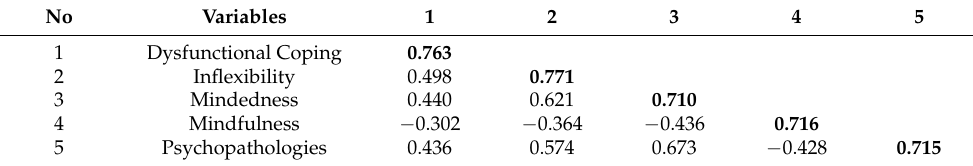
Table 2. Discriminant validity: